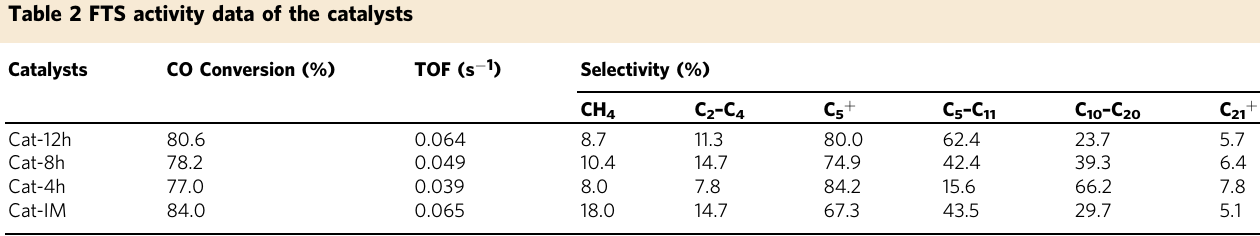
Table 2 FTS activity data of the catalysts